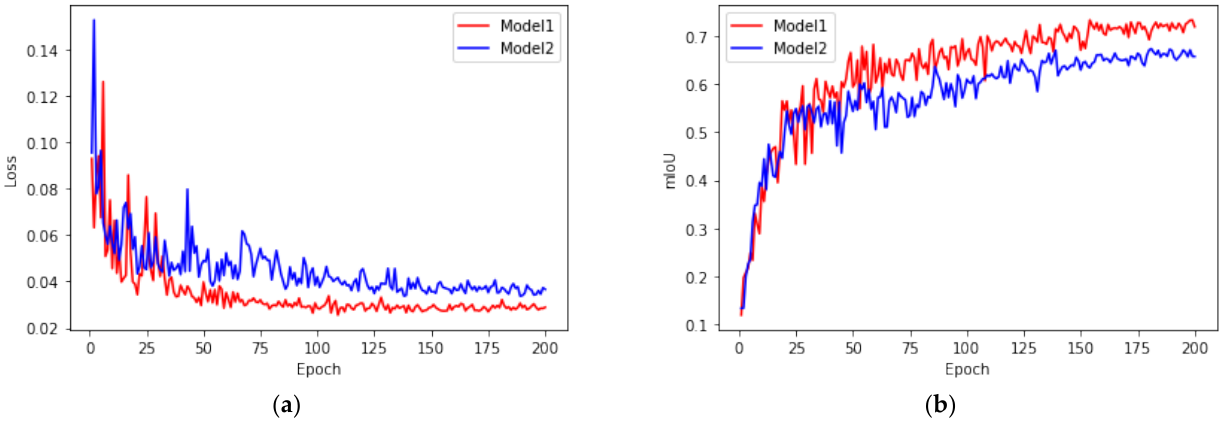
Figure 6 . The loss and mIoU of Model 1 and Model 2 on the test set during the training process: ( a ) loss; ( b ) mIoU.